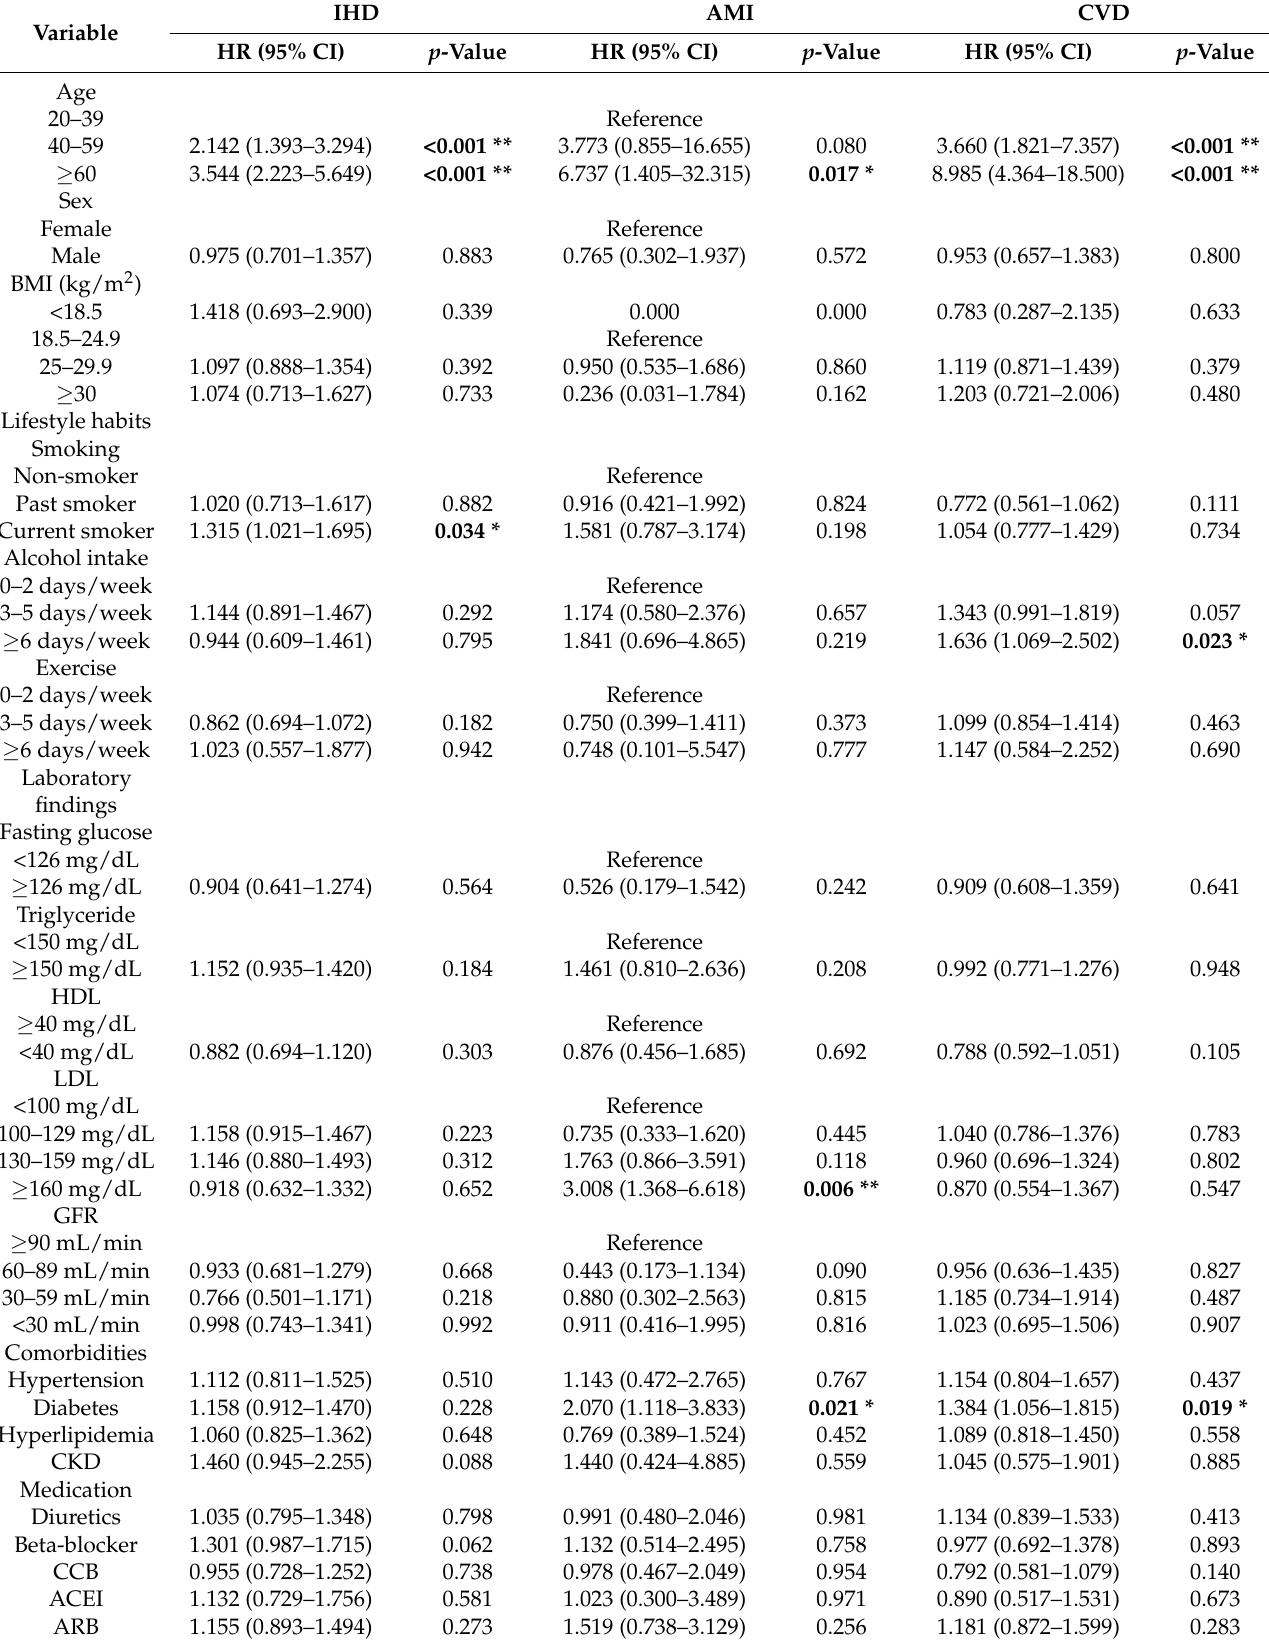
Table 3. Multivariate Cox proportional HRs for IHD, AMI, and CVD in gout